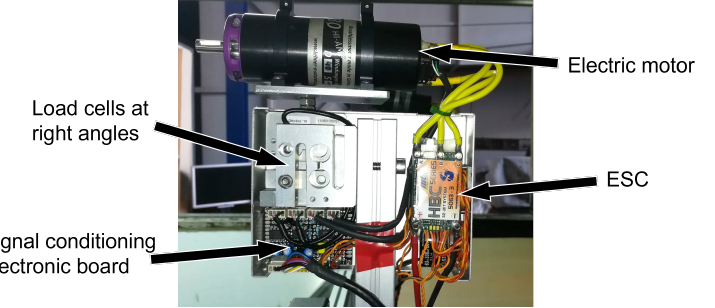
Figure 9. Details of electronics for data acquisition of the propulsive forces and signal conditioning for motor